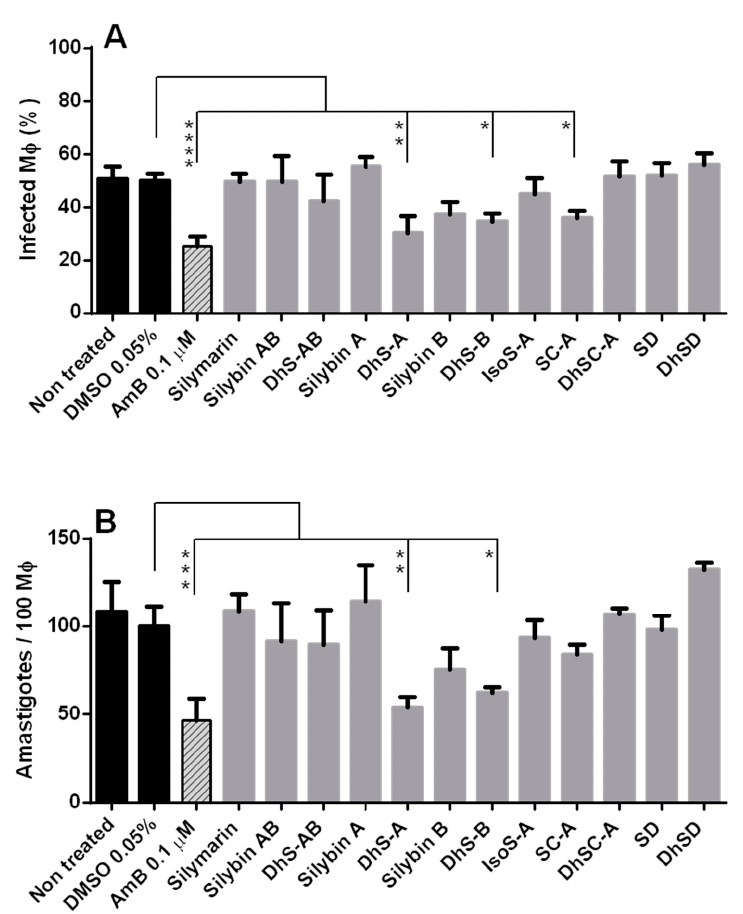
Figure 4. Effect of silymarin and related flavonolignans (10 µM) on the infection (%) of BALB/c mice peritoneal macrophages (M φ ) ( A ) and the number of amastigotes/100 M φ ( B ) of Li BCN150.